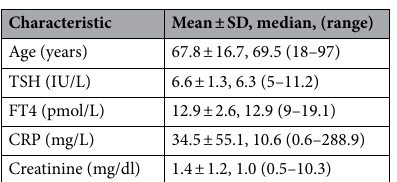
Table 1. Baseline characteristics in first hospitalization. FT4 free T4, CRP C-reactive